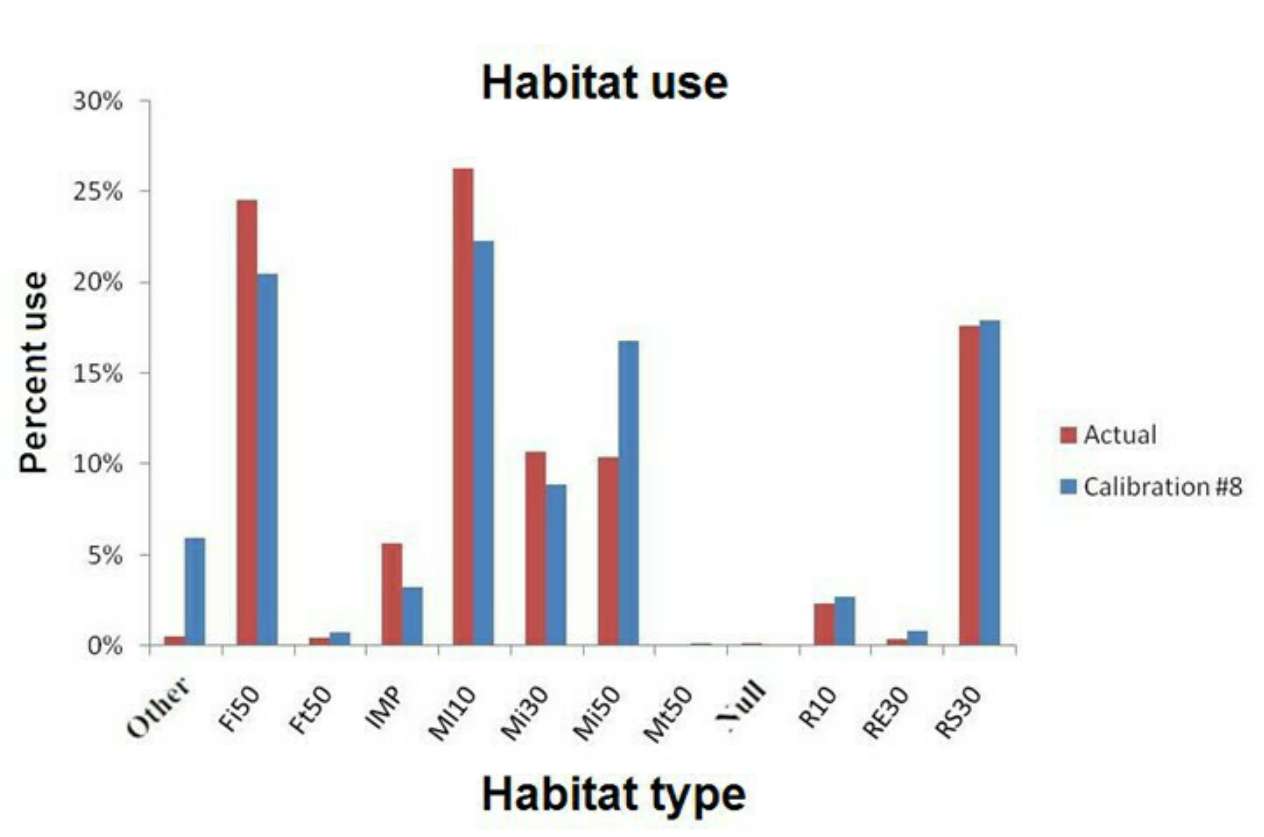
Fig. 5 . The habitat use of calibration run #8 compared to the actual habitat use of the 12 real moose. In calibration run #8, the top three habitat types were fairly close to actual moose habitat use. See Table 1 for a description of the habitat